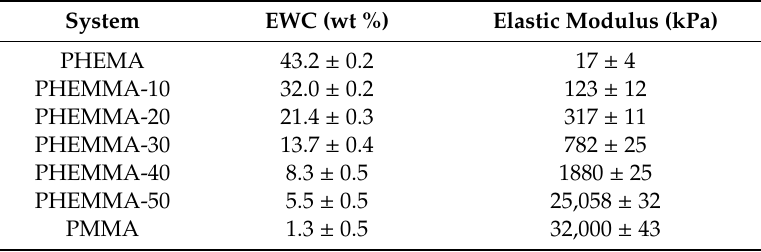
Table 6. Water content at equilibrium and the apparent Young’s modulus of the pure homo-polymers and the PHEMMAC copolymer specimens with di ff erent compositions.